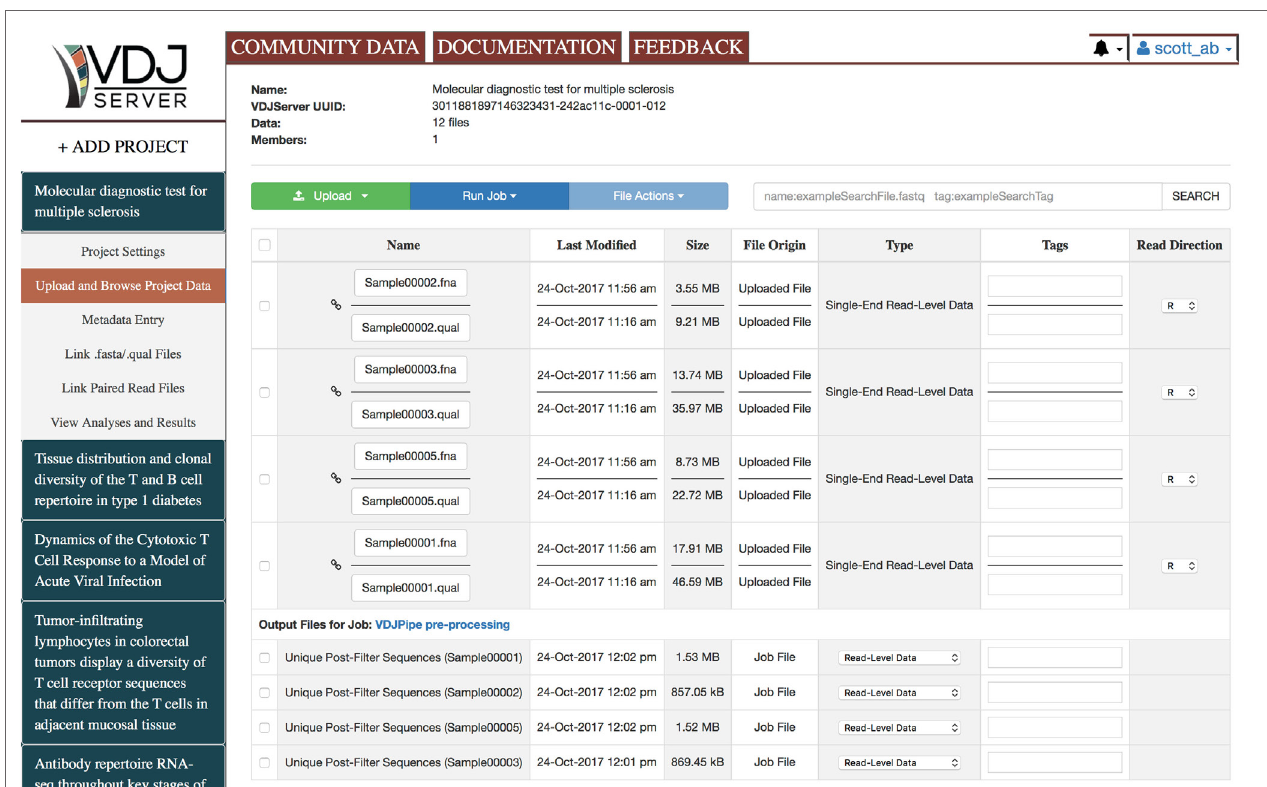
FIguRe 2 | Web browser interface for Project Data Management. Along the top of the screen are tabs for Community Data, which displays public projects, Documentation, which opens up the documentation webpage in a new browser window, and Feedback, which allows you to send a message or ask a question. The left panel provides the list of user projects and the button to add a new project. When a project is selected, a submenu is shown to navigate the primary views: Project Settings, Upload and Browse Project Data, Metadata Entry, Link.fasta/.qual Files, Link Paired Read Files, and View Analyses and Results. The current view shown is Upload and Browse Project Data, which shows the list of user-uploaded files and some output files from a VDJPipe preprocessing job. The top of the view has project information, buttons for uploading files and running analysis jobs, and a search window to narrow the list of files